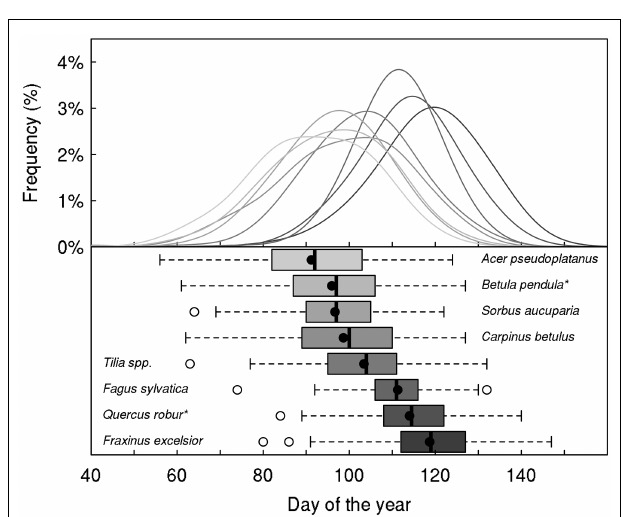
FIGURE 2 | Daily variation of minimum air temperature at five extreme locations within the distribution of Fagus sylvatica (see Figure 1 for the location of the sites) for a same date among the five locations (A, spatial scale), and within a site for the same day of the year across years from 1900 to 2010 (B, temporal scale). Note that the extent of temperature variation within a site for a given day exceed the maximum variation of temperature that occurs at a given date between the two extreme locations of the distribution area of the species.